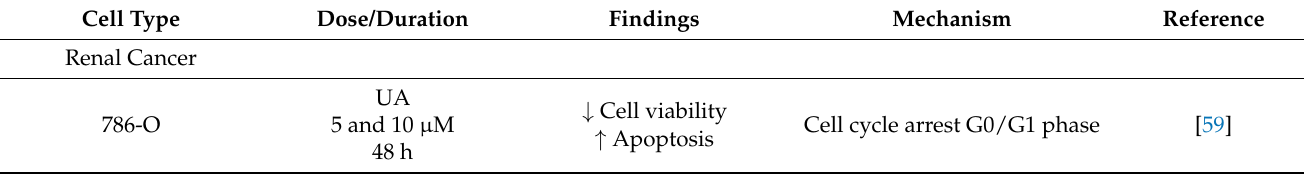
Table 3. Effects of ursolic acid against renal and bladder cancers: summary of existing